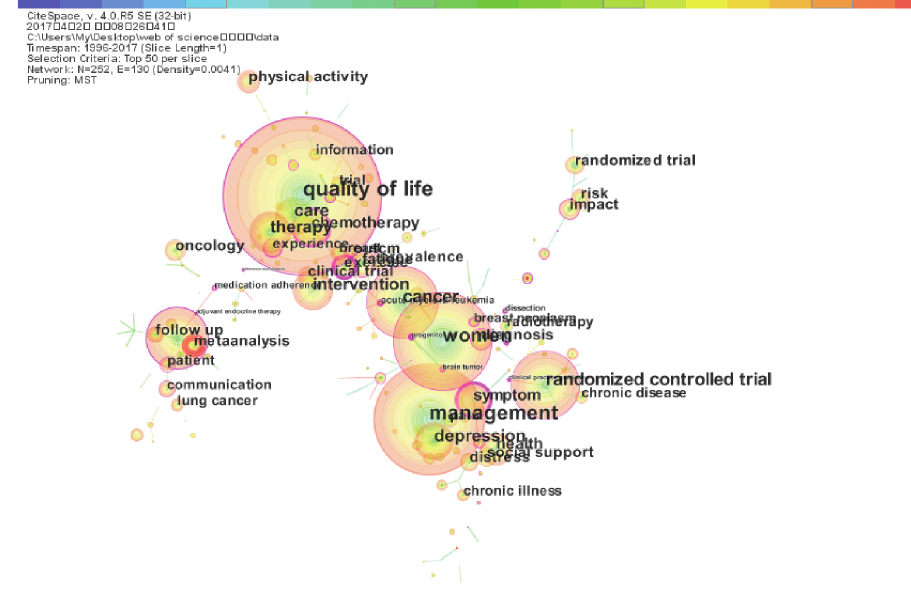
Figure 3. Network of co-words used in research papers on self-management by patients with breast cancer (one-year slices).